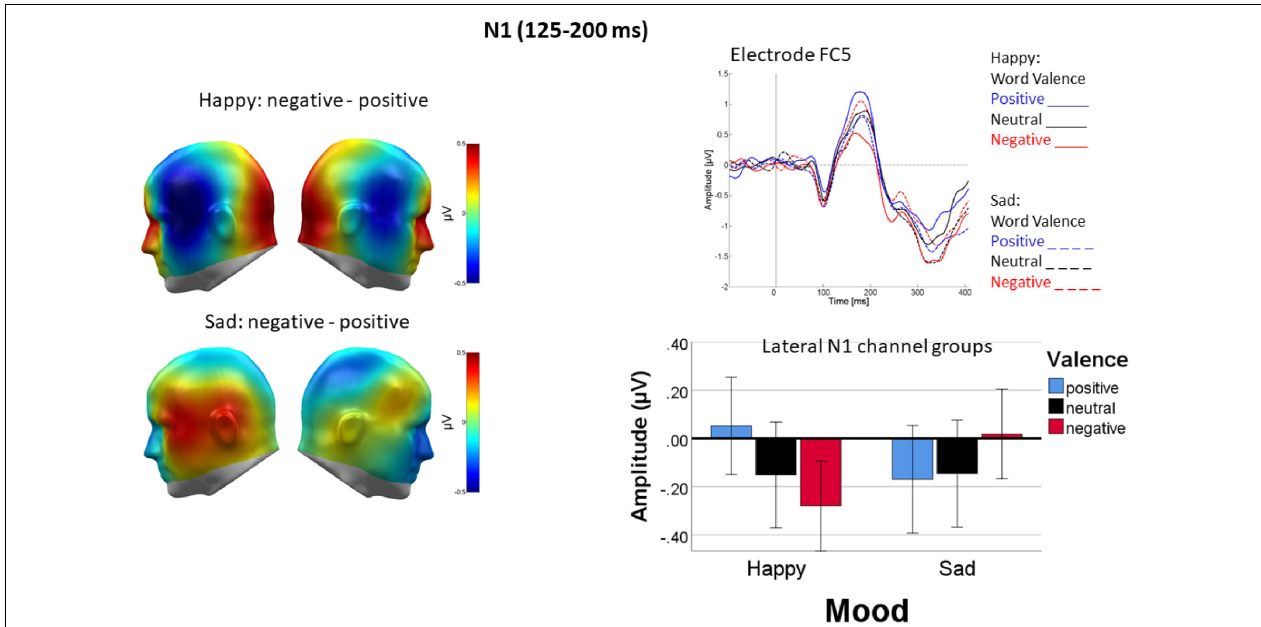
FIGURE 4 | Differential processing of negative versus positive words over temporal cortices following happy but not sad mood induction. Left panel : Difference topographies of average activity in the N1 time window (125–200 ms). Right panel : Representative sensor FC5 (top) and bar plot showing mean activity averaged across both temporal sensor groups. Error bars are standard errors.